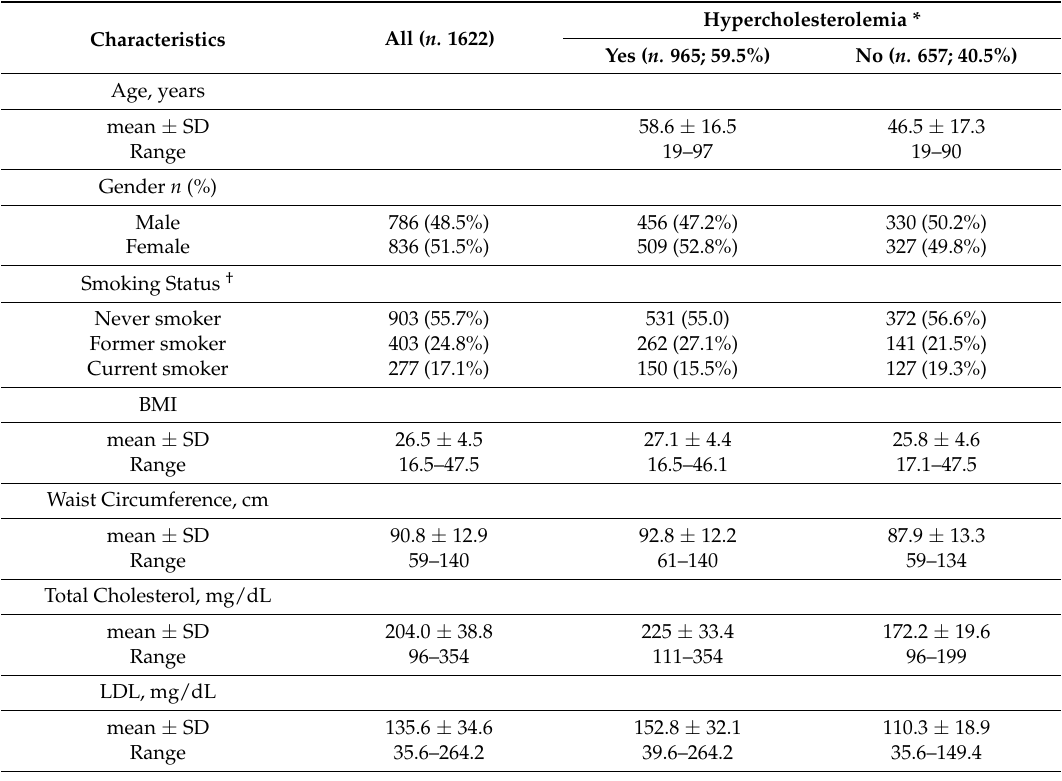
Main demographic, clinical and laboratory characteristic of the Brisighella population—the hypercholesterolemic group included individuals with total cholesterol >200 mg/dL and subjects under therapy with